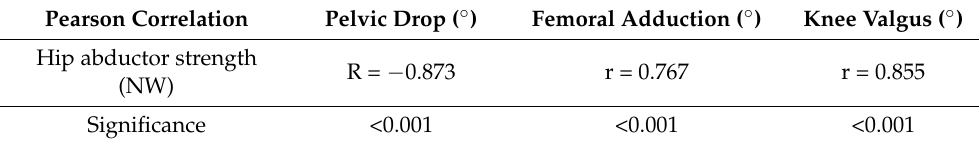
Table 3. Correlation analysis. Pearson